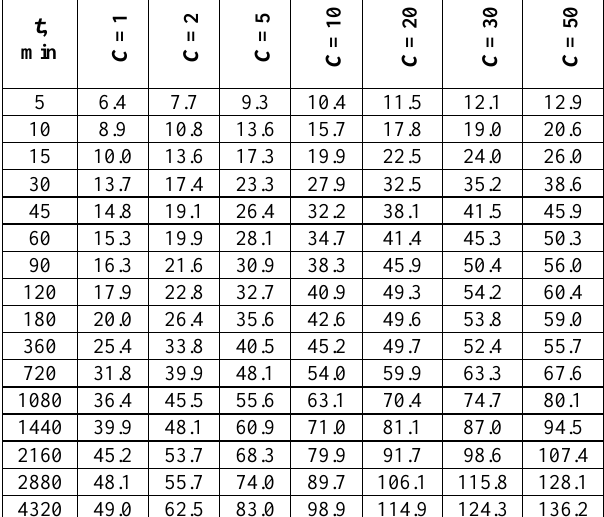
Table 3. Theoretical rainfall amounts determined on the basis